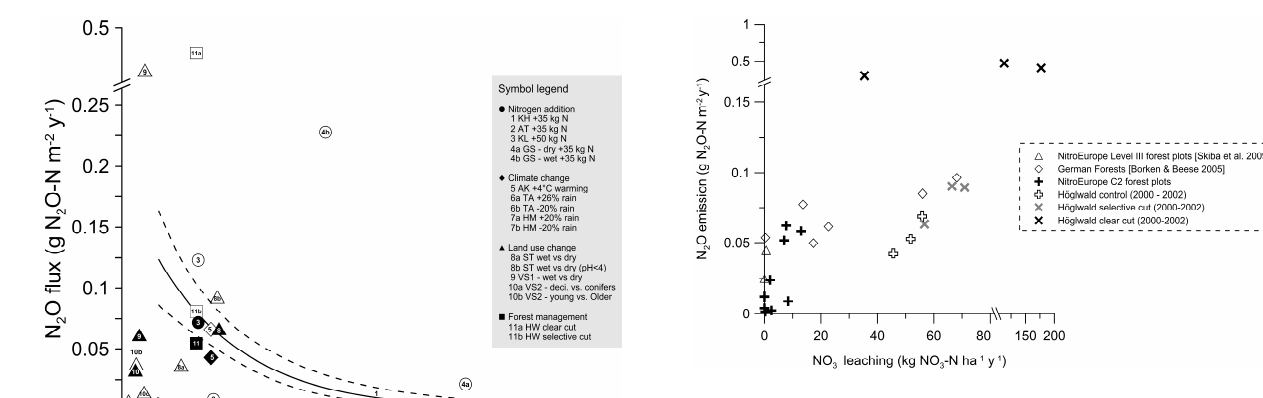
Fig. 5. Nitrogen losses from forest soils plotted as N 2 O emission versus NO − leaching below the root zone for forest change sites 3 (crosses) and other European forests (see legend). H¨oglwald (HW) treatments are represented with data from 3 individual years, where nitrate leaching data were taken from Huber et al. (2004, 2010). Note the breaks on both